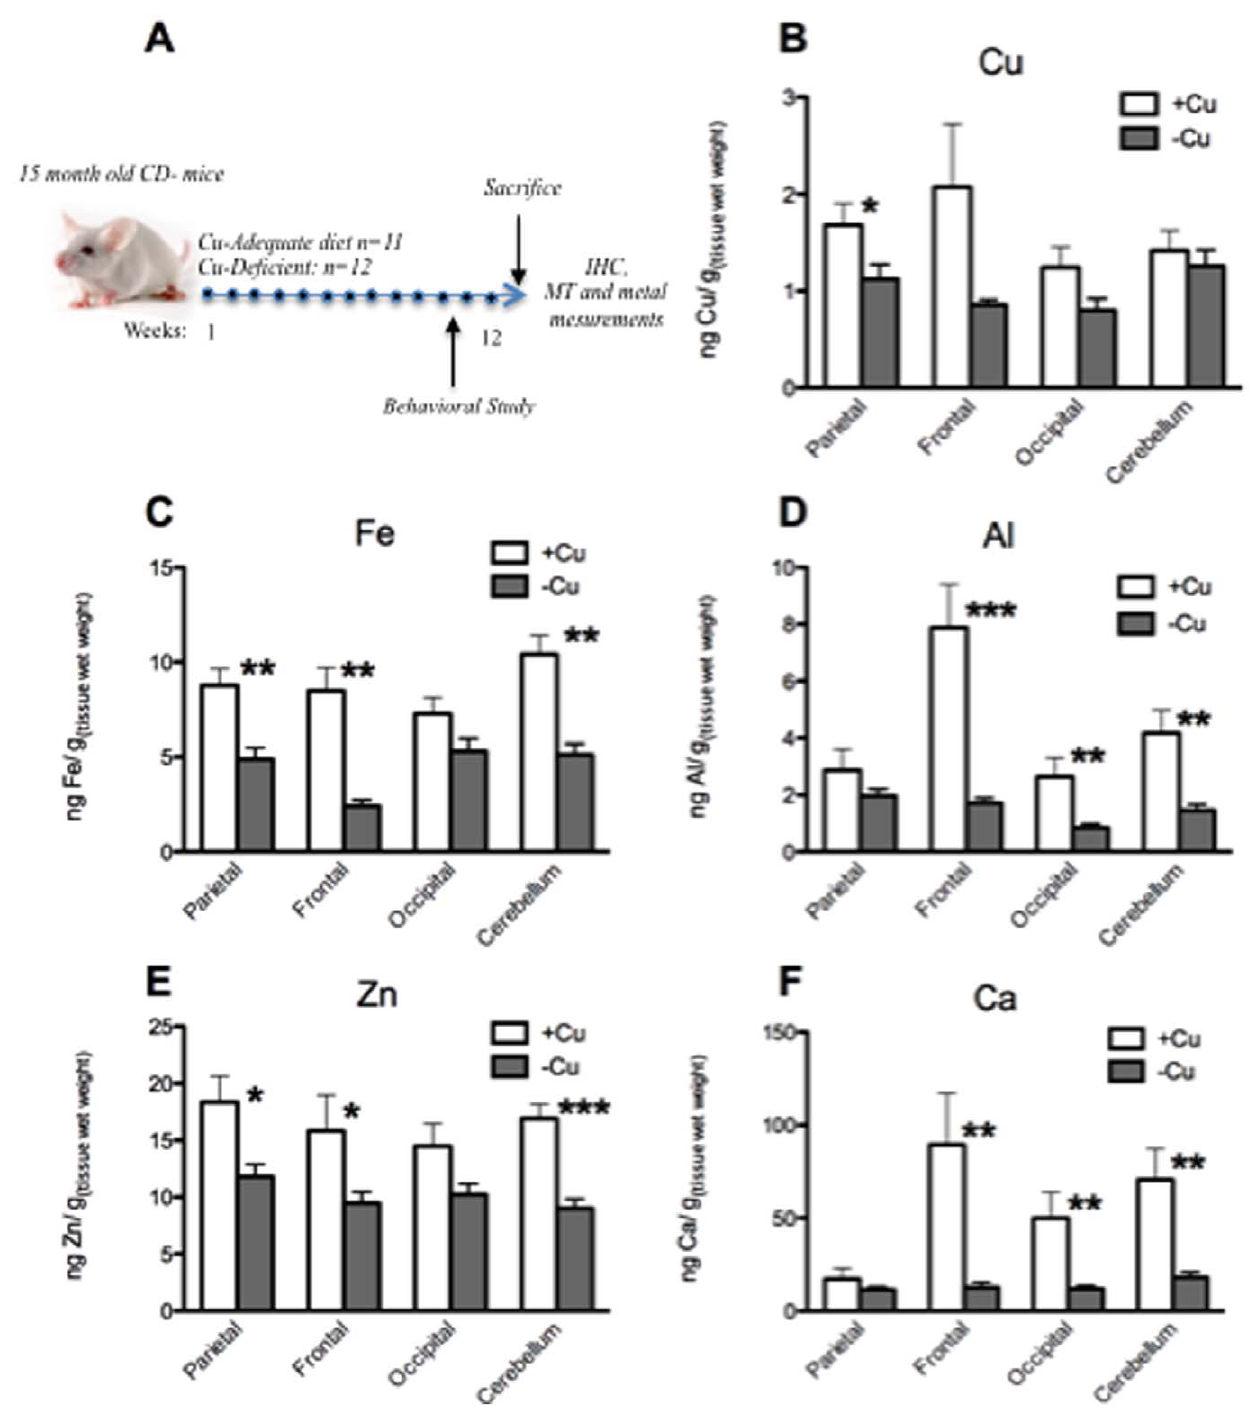
Figure 1. Metal content in the brain. (A) Schematic representation of the outline of the study. 15 month old CD1 mice were fed with a Cu- adequate (CuA) or Cu-deficient (CuD) diet for 12 weeks. Behavioural tests were performed the last 2 weeks of the treatment. Mice were then sacrificed and metal determination, IHC as well as biochemical investigations were performed. (B) Cu, (C) Fe, (D) Al, (E) Zn, and (F) Ca content ( m g/g wet tissue) in the parietal, frontal, occipital cortex, and cerebellum. * p , 0.05; ** p , 0.01; *** p , 0.001. doi:10.1371/journal.pone.0047063.g001 weighted every day and tested neurologically with special emphasis Tests were chosen to explore different cognitive, sensory, motor on: general condition, deambulation, posture, righting from the and emotional domains; data were analyzed with mixed design ANOVA using Statistica software version 5 ’97 edition (www. side, placing reaction of hindlimbs, geotaxic reaction, avoiding of borders and equilibrium. statsoft.com). The significant level was set at p , 0.05.